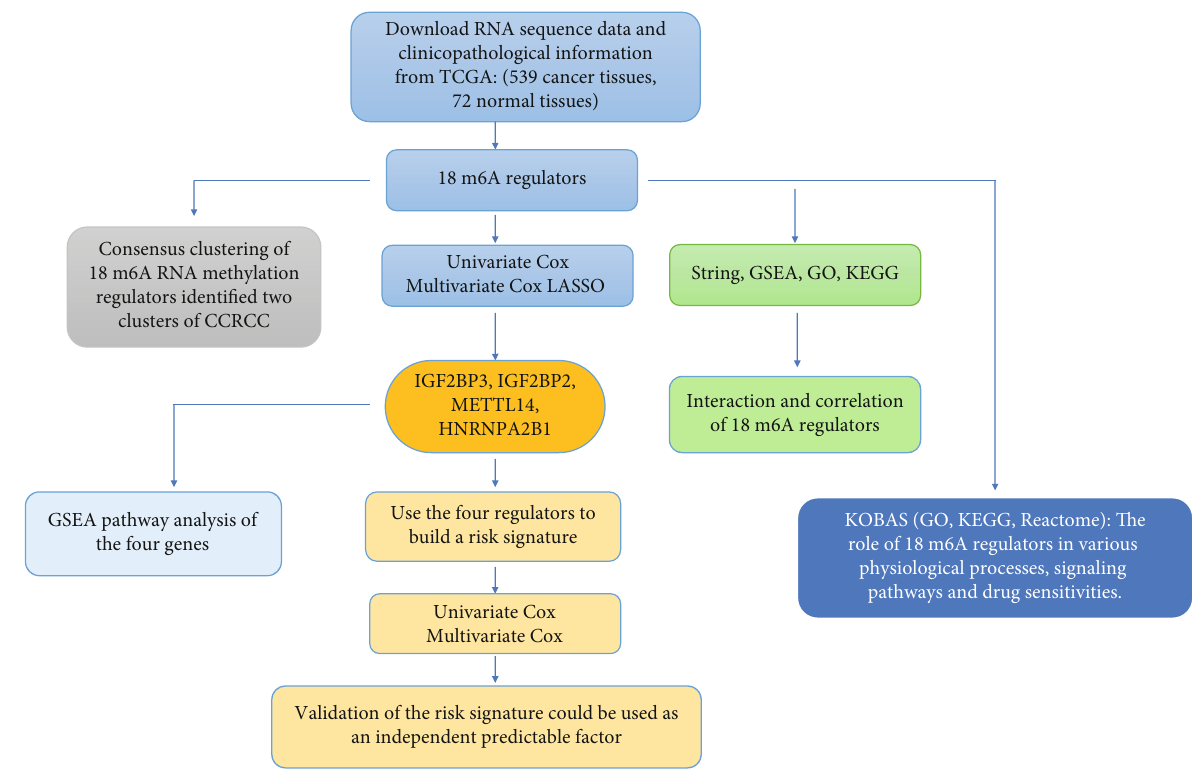
Figure 10: The fl owchart of this